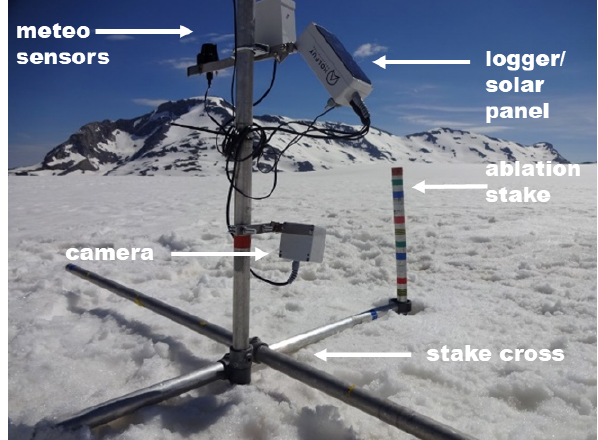
Figure 2. The camera setup used to obtain daily estimates of glacier point mass balance. Here, the camera has just been mounted on the snow-covered surface of Glacier de la Plaine Morte (19 June